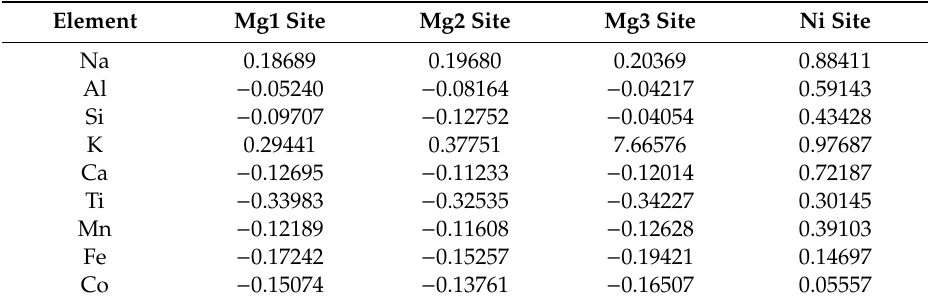
Table 2. The calculated formation energies (eV) of di ff erent doping atoms and sites for Mg 2 NiH 4